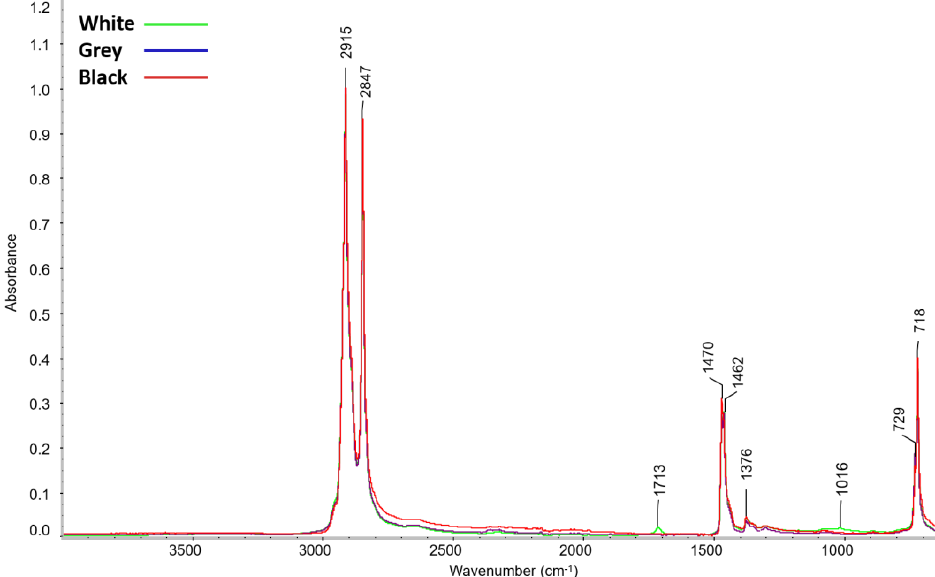
Figure 4. ATR-FTIR spectra of the tested PE foams after artificial ageing.